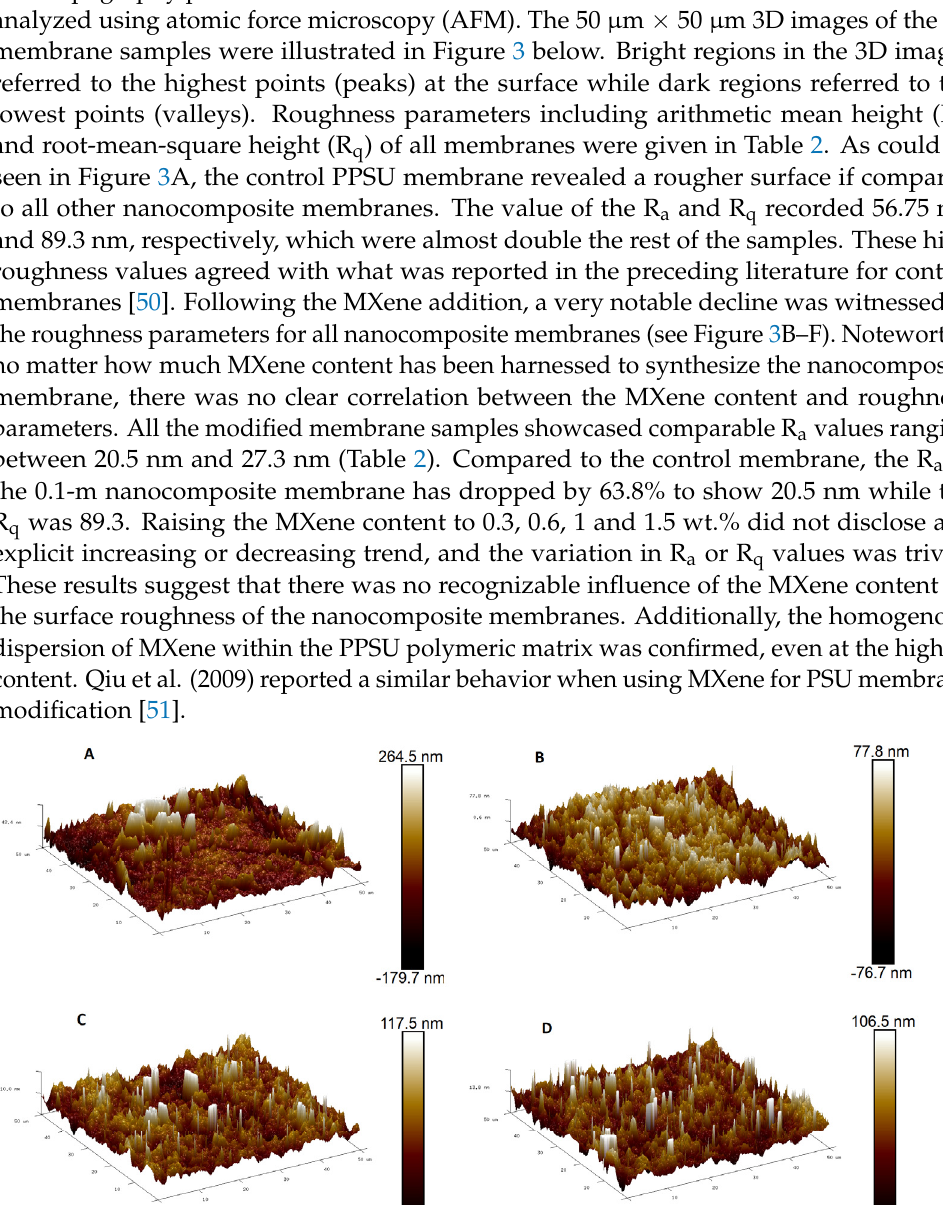
Table 2. Roughness parameters over a 50 × 50 µm scan size.